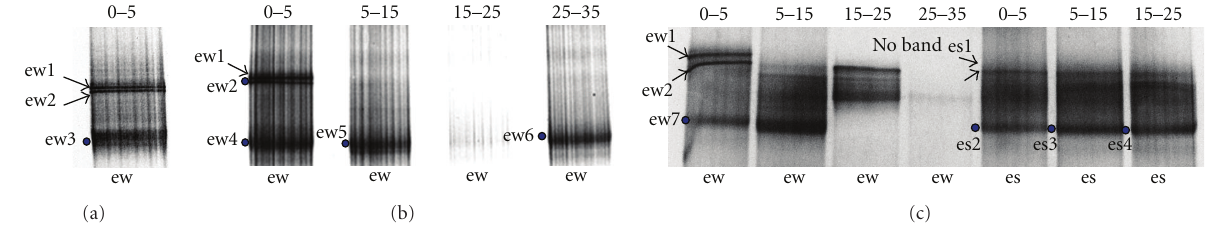
Figure 4: DGGE pattern of PCR-amplified McrA gene fragments from environmental sediment samples. (a) winter pattern (0–5cm depth), (b) winter patterns obtained from di ff erent depths, and (c) Winter (ew) and summer (es) patterns from di ff erent depths (cm). Bands across several lanes were identified as being in the same genera, and the arrow for ew1 shows its absence in the 0–5 cm depth summer sample (es). Band mcr-es5 is not shown in the